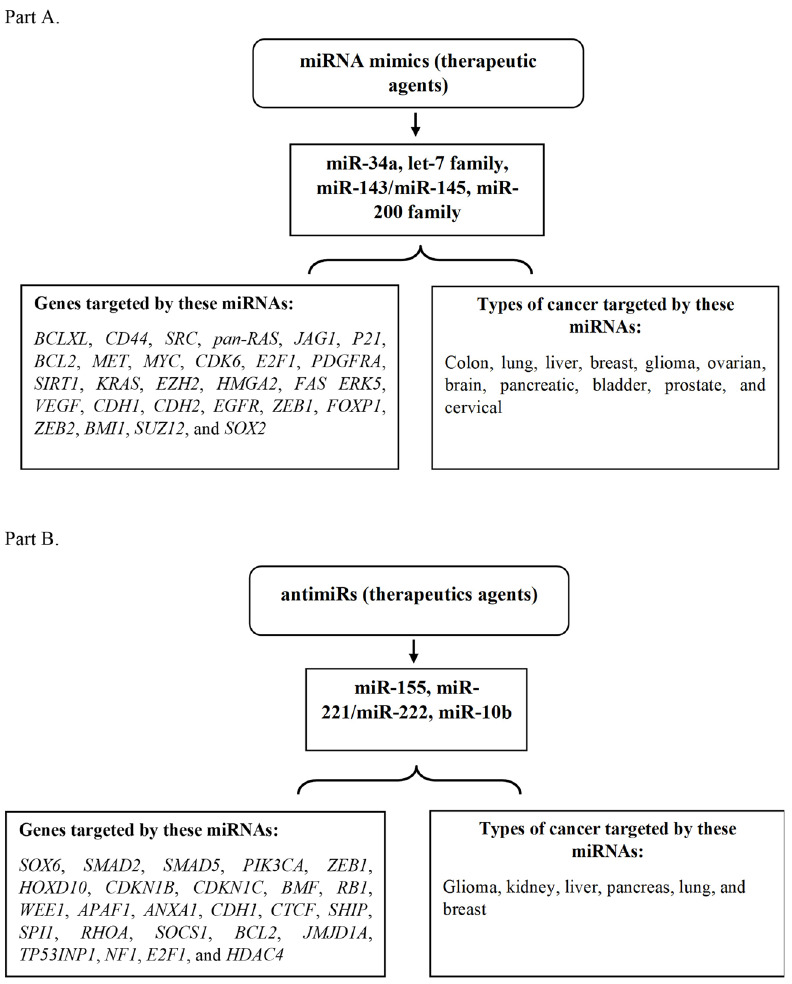
Figure 2. Tumor suppressive and Oncomeric miRNAs therapeutic as mimics and antimiRs. Part (A): depiction of some of the miRNA mimics as therapeutic agents targeting genes and various types of cancer. Part (B): illustration of a few of the miRNA antimiRs as therapeutic agents targeting the genes and different kinds of cancer. KRAS : KRAS proto-oncogene; BCL2 : B-cell lymphoma 2 Table 1. List of miRNAs based therapeutics in their clinical trials Therapeutics